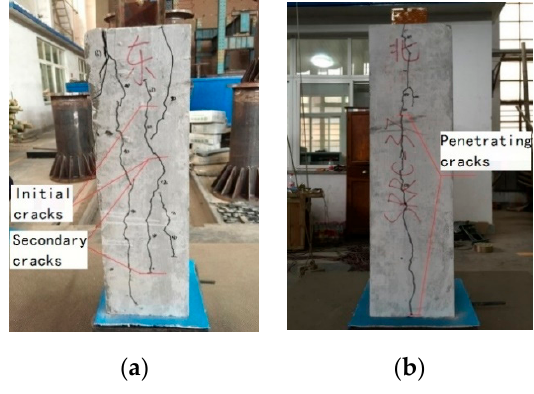
Figure 5. Bursting failure of SRRC-1: ( a ) web; ( b ) flange.